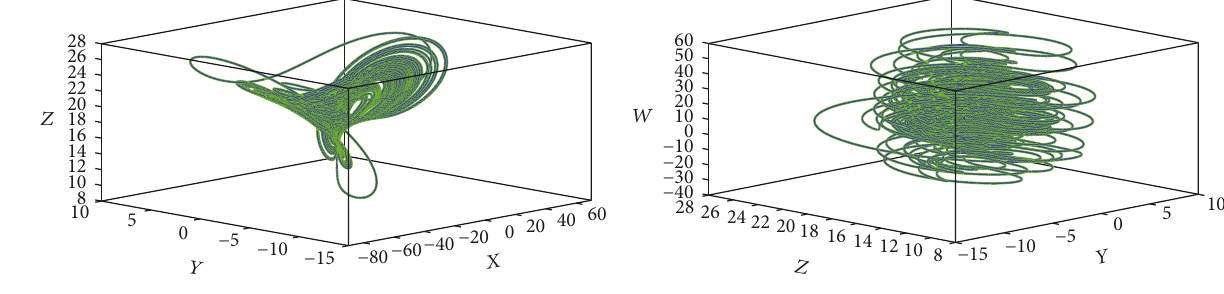
Figure 1: 3D phase portraits of NCS 1 system.